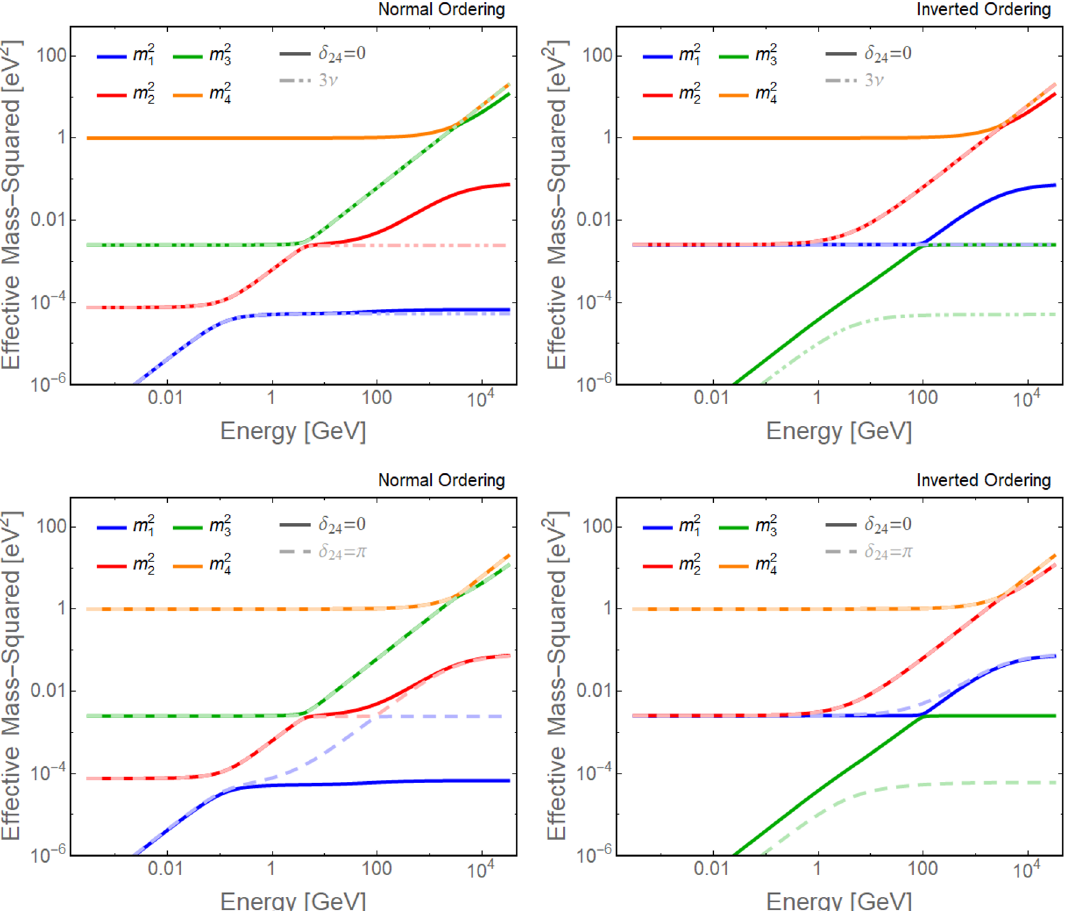
Figure 1 . Effective mass-squared values, representing the eigenvalues of eq. (1.1) for neutrinos in both normal (left) and inverted (right) orderings, as a function of neutrino energy. Three models are shown: in the upper panels, the standard picture with three active neutrinos (3 ν ), is compared to a model with one light sterile neutrino where the CP violating phase δ 24 is set to 0 . In the lower panels, two sterile neutrino models are compared with δ 24 set to either 0 or π . The absolute mass scale has been chosen so that the lightest neutrino is massless in vacuum. The oscillation parameters were set to ∆ m 2 = 7 . 5 × 10 − 5 eV 2 , | ∆ m 2 | = 2 . 5 × 10 − 3 eV 2 , | ∆ m 2 | = 1 eV 2 , s 2 = 0 . 3 , s 2 = 0 . 02 , 21 31 41 12 13 s 2 = 0 . 57 , s 2 = 0 . 01 , s 2 = s 2 = 0 . 04 , and δ 13 = δ 14 = 0 . The matter density is set to 8.5 g/cm 3 23 14 24 34 with a ratio N n /N e = 1 . 08